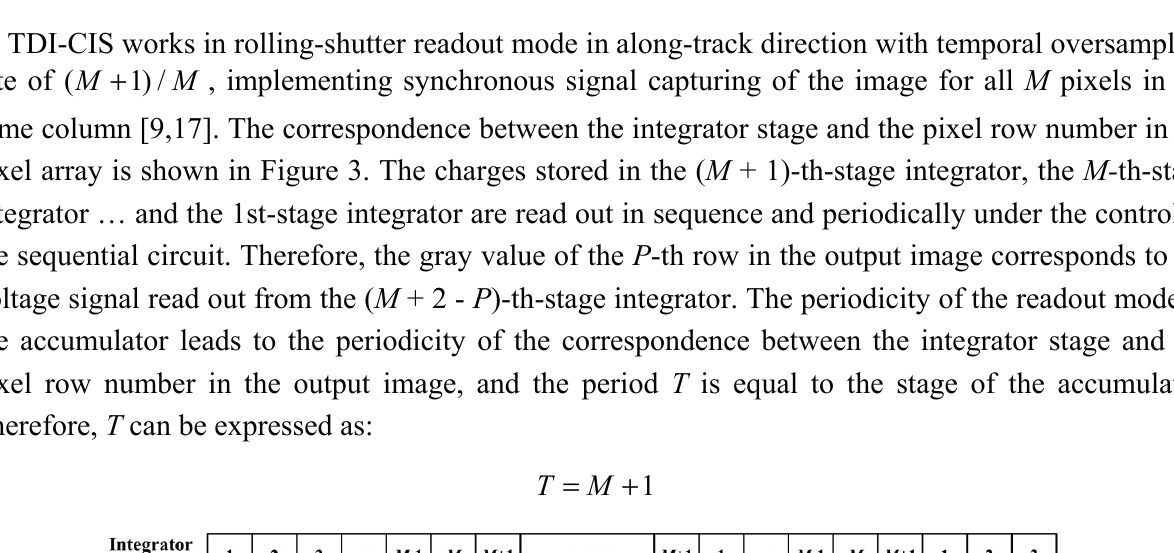
Figure 2. Circuit structure of the column-parallel accumulator.